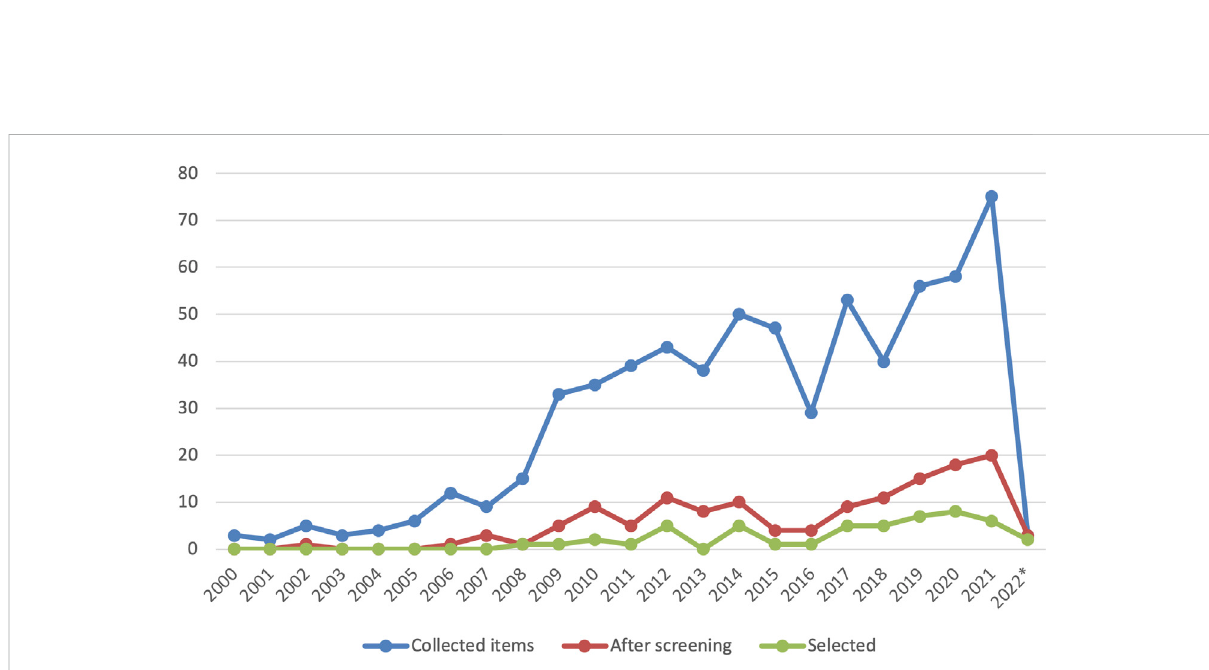
FIGURE 4 Division of collected and selected items according to published year. *Database searching was conducted in January 2022, thus the Year 2022 only yields two selected item.